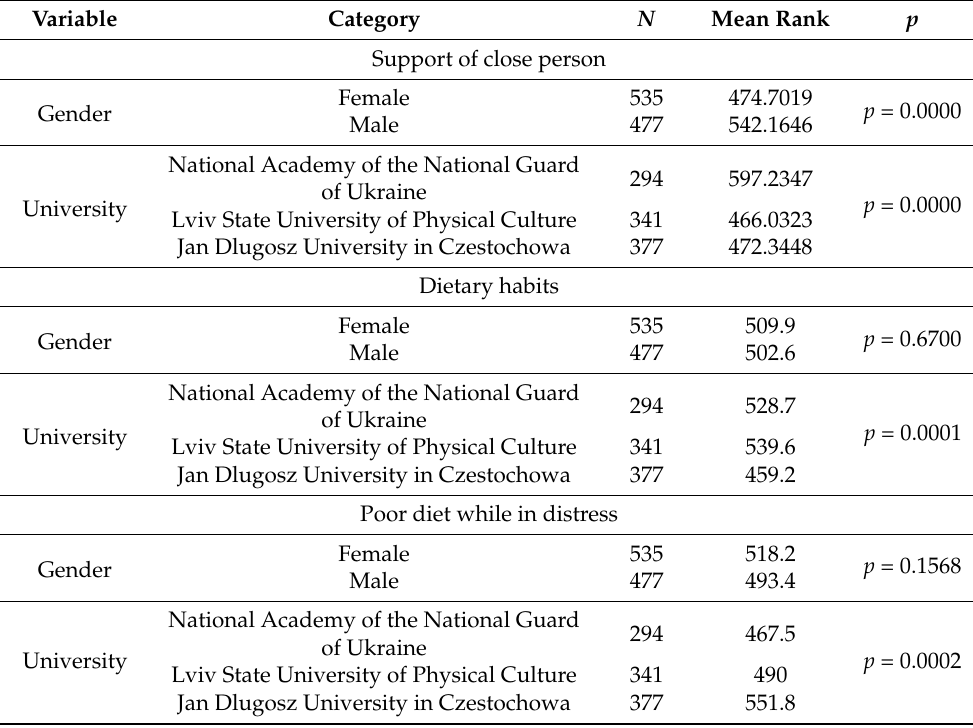
Table 4. Kruskal–Wallis ANOVA by gender and university differences of STAI items and supplemen- tary questions ( p <